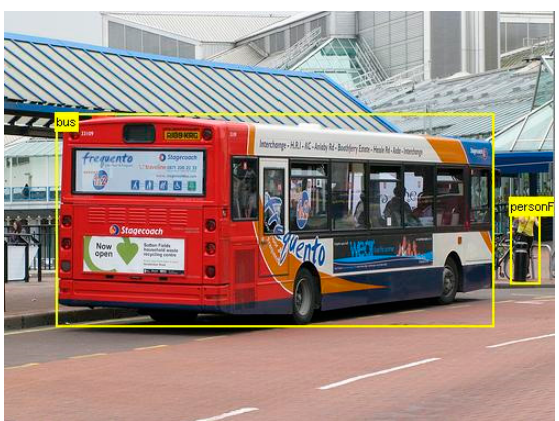
Figure 1. An image in the Pascal VOC dataset [10], in which a bus and a person are marked by yellow boxes.